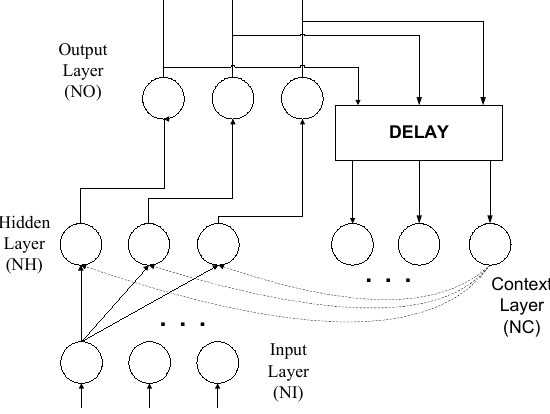
Fig. 2 Basic architecture of Jordan Recurrent Neural